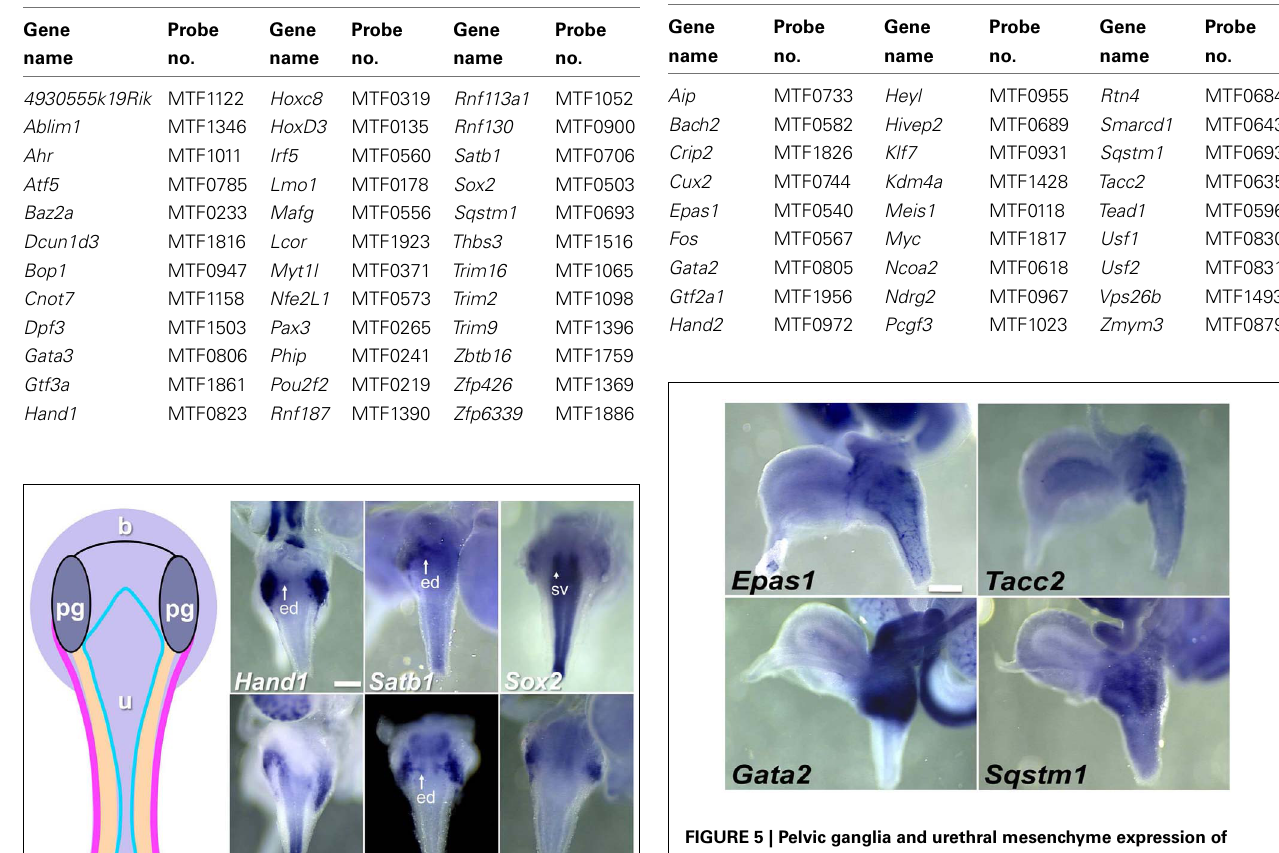
Table 3 | Genes detected in pelvic ganglia and LUT mesenchyme.